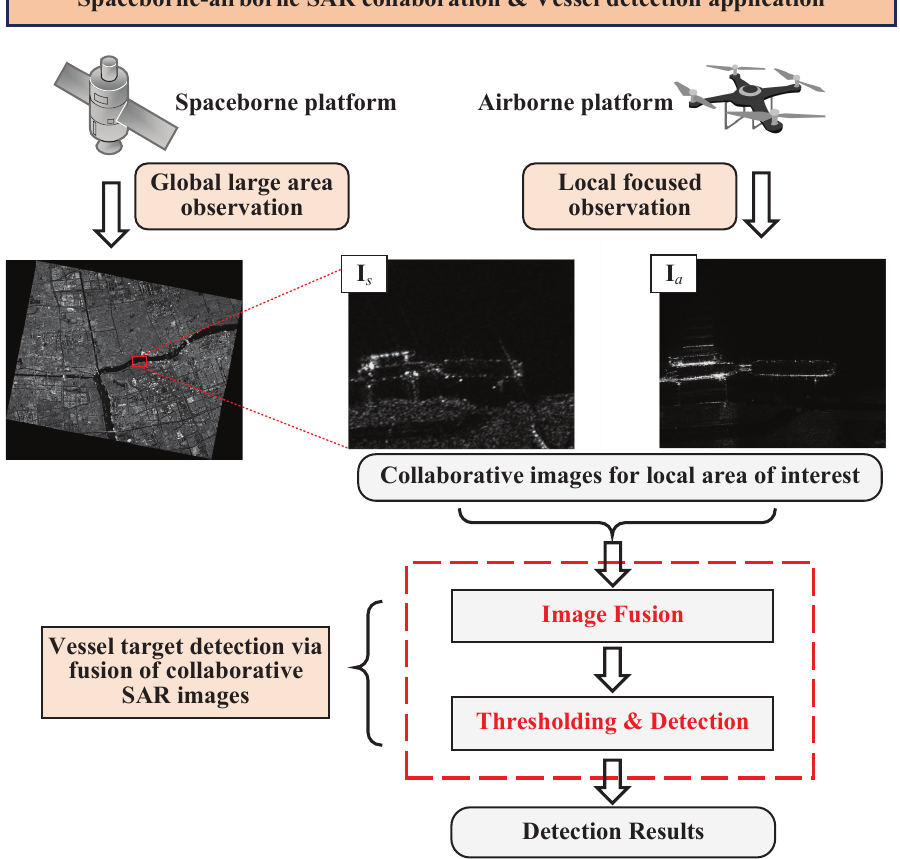
Figure 1. Process of spaceborne–airborne collaborative SAR observation and the associated vessel target detection task. In more detail, the spaceborne platform achieves the global large area observa- tion and the airborne platform achieves the local focused observation. For the local area of interest, the collaborative spaceborne SAR image I s and airborne SAR image I a are fused in a certain manner. Then, the fused image is used for thresholding and vessel target